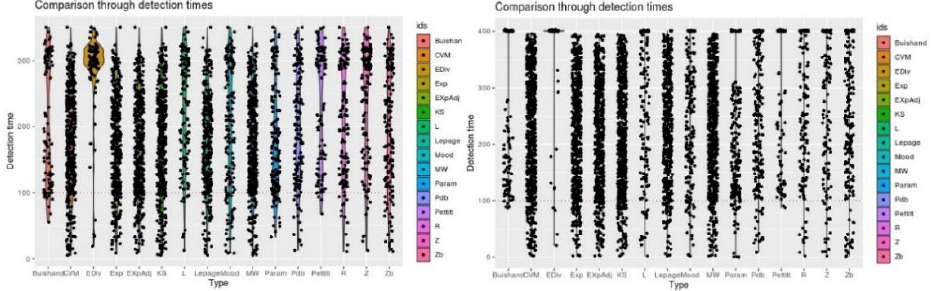
Fig. 4. Change identification under β : 3.8 → 0.8: left panel - failure truncation, right panel - time truncation.